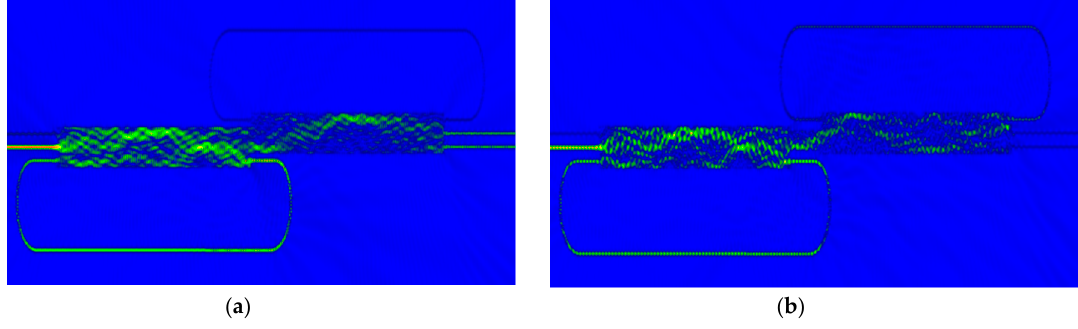
Figure 9. FDTD simulations for input signal at input port 2 for the EIT scheme of Figure 5a,b λ = 1550 nm.